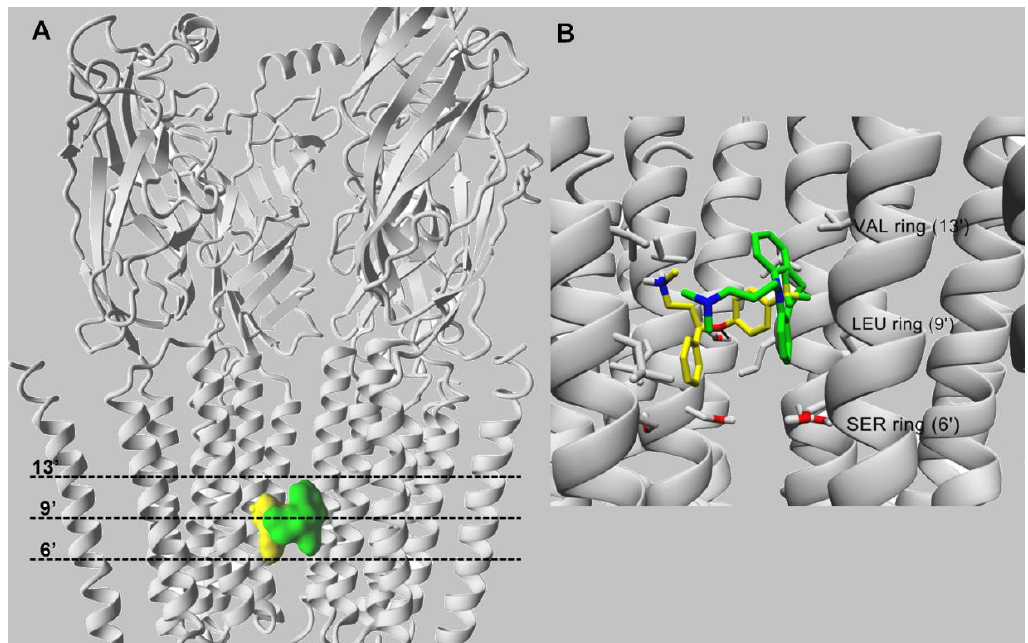
Figure 3. Molecular docking of fluoxetine (in yellow) and imipramine (in green), both in the protonated state, within the α4β2 nAChR ion channel (modified from [70]). ( A ) Side view of the overlapping binding sites for both ligands that interact with the middle portion of ion channel. ( B ) Imipramine (in green) and fluoxetine (in yellow) interact with the M2 transmembrane segments forming the lumen of the α4β2 nAChR ion channel. Both ligands interact mainly through van der Waals contacts with a domain formed between the valine (VAL) (position 13′) and serine (SER) (position 6′) rings. In addition, the black arrow indicates the hydrogen bond formed between the oxygen atom of fluoxetine and the hydroxyl group of α4-Ser251 (position 10′). For clarity, one β2 subunit is hidden. Residues involved in ligand binding are presented in stick mode (gray), whereas ligands are rendered either in the ball ( A ) or stick mode ( B ). All non-polar hydrogen atoms are hidden.